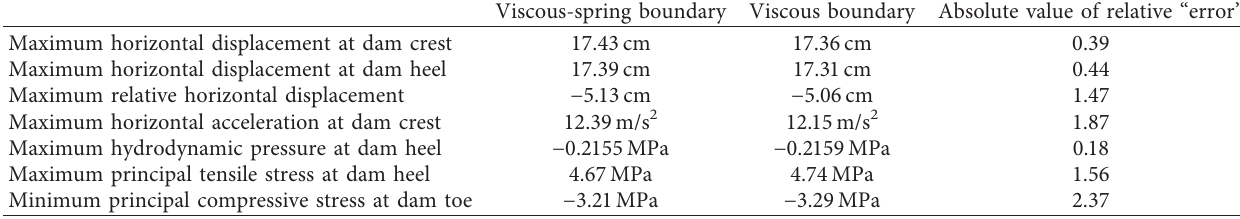
Table 1: Result comparisons of the Pine Flat dam using different models.